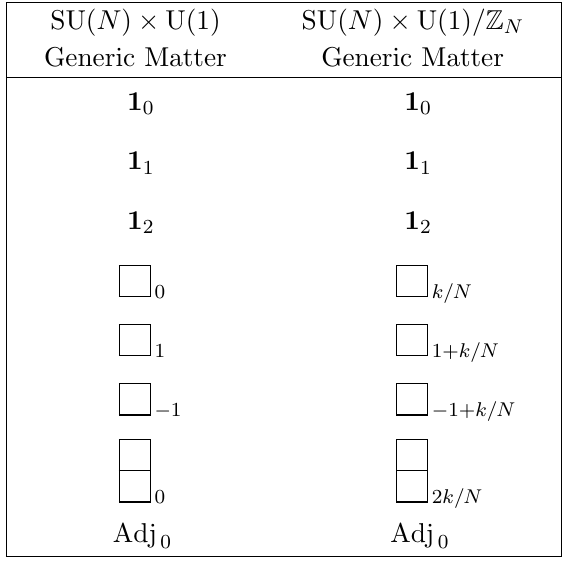
Table 4 . Generic matter representations for gauge groups SU( N 1 ) (cid:2) U(1) and SU( N 1 ) (cid:2) U(1) = Z N . Here, k 2 Z is determined by the embedding of the Z N in the center of SU( N ) (cid:2) U(1), and we have (cid:0) N= 2 < k (cid:20) N= 2. If k is not relatively prime to N , then the quotient reduces to a quotient by the relevant subgroup of Z N , which is the trivial group for k =